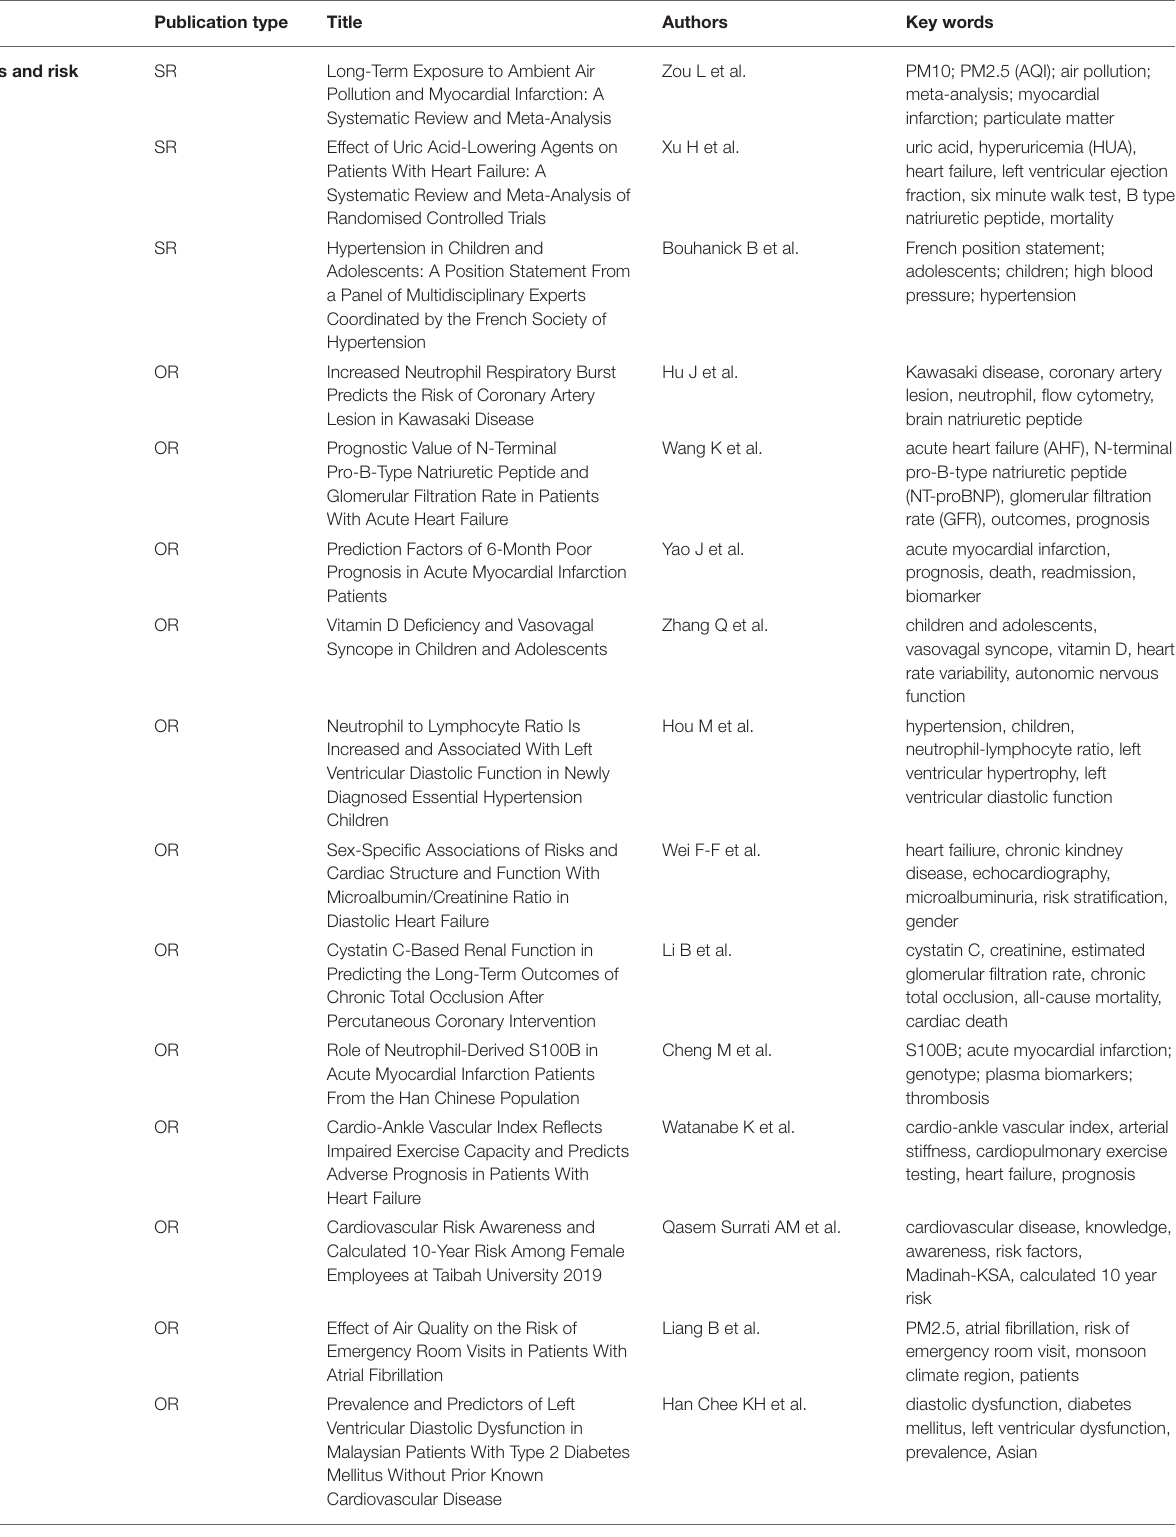
TABLE 1 | List of manuscripts included in the special